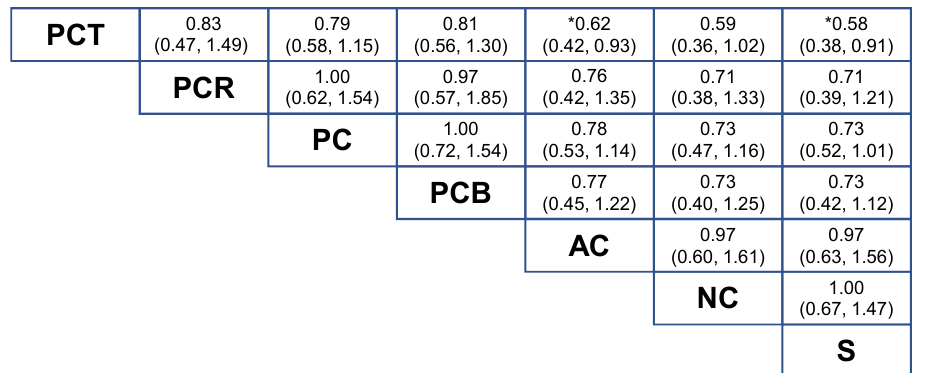
Figure 4. Results of the treatment-strategy random effects network meta-analysis (NMA-1) for seven different strategies in terms of overall survival. Relative effects in combined hazard ratios and 95% credible intervals are shown for the combination chemotherapy regimens. The hazard ratio for a given comparison could be read in the intersection of two treatments. The strategies are grouped according to their baseline efficacy compared with surgery-alone. All z-tests to compare two treatments were performed two-sided. * p < 0.05. Abbreviations: AC = adjuvant chemotherapy; NC = neoadjuvant chemotherapy; PC = perioperative chemotherapy regimens without a taxane; PCB =